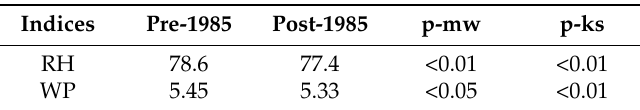
Table 4. Statistical difference tests for the mean and distribution in the RH (%) and WP (hPa) between pre-1985 and post-1985 periods.